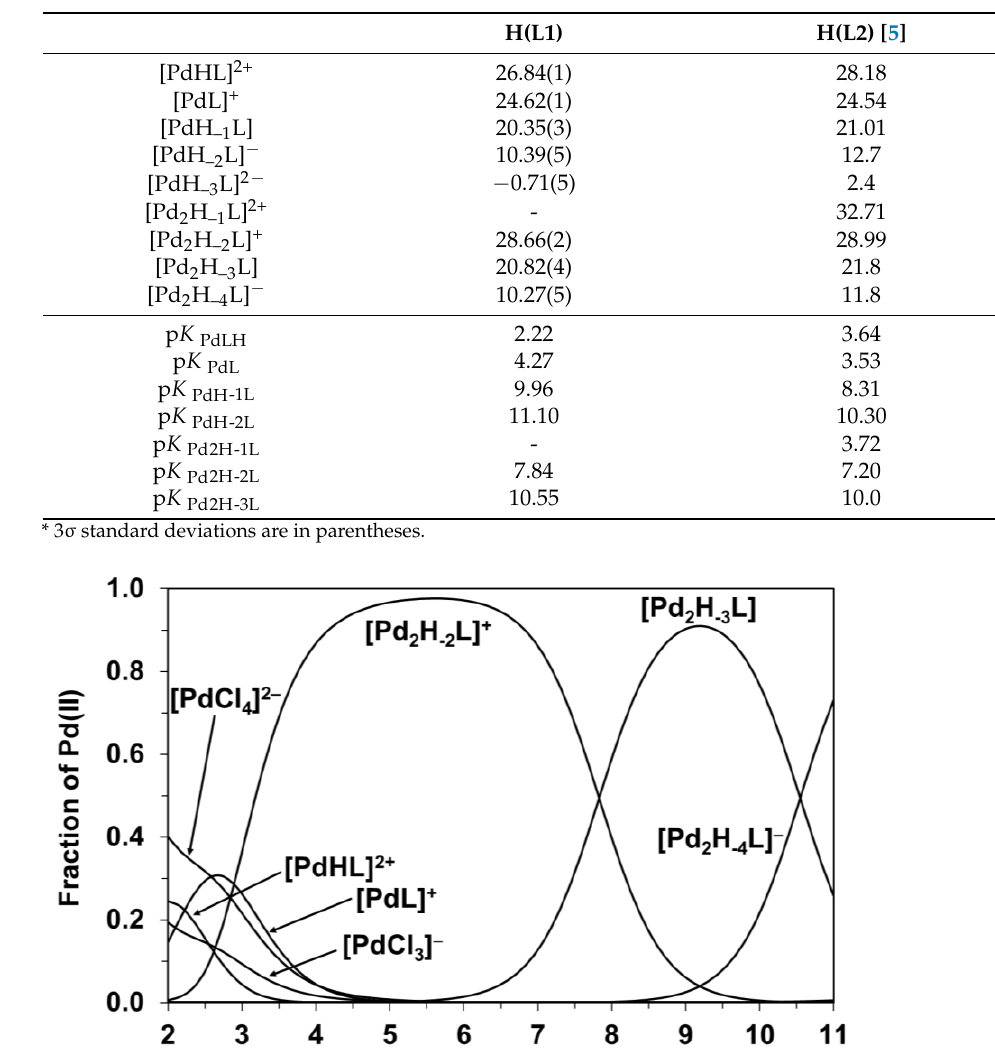
Table 2. Overall stability constants (log β ) of the Pd(II) complexes formed with H(L1) and H(L2) at